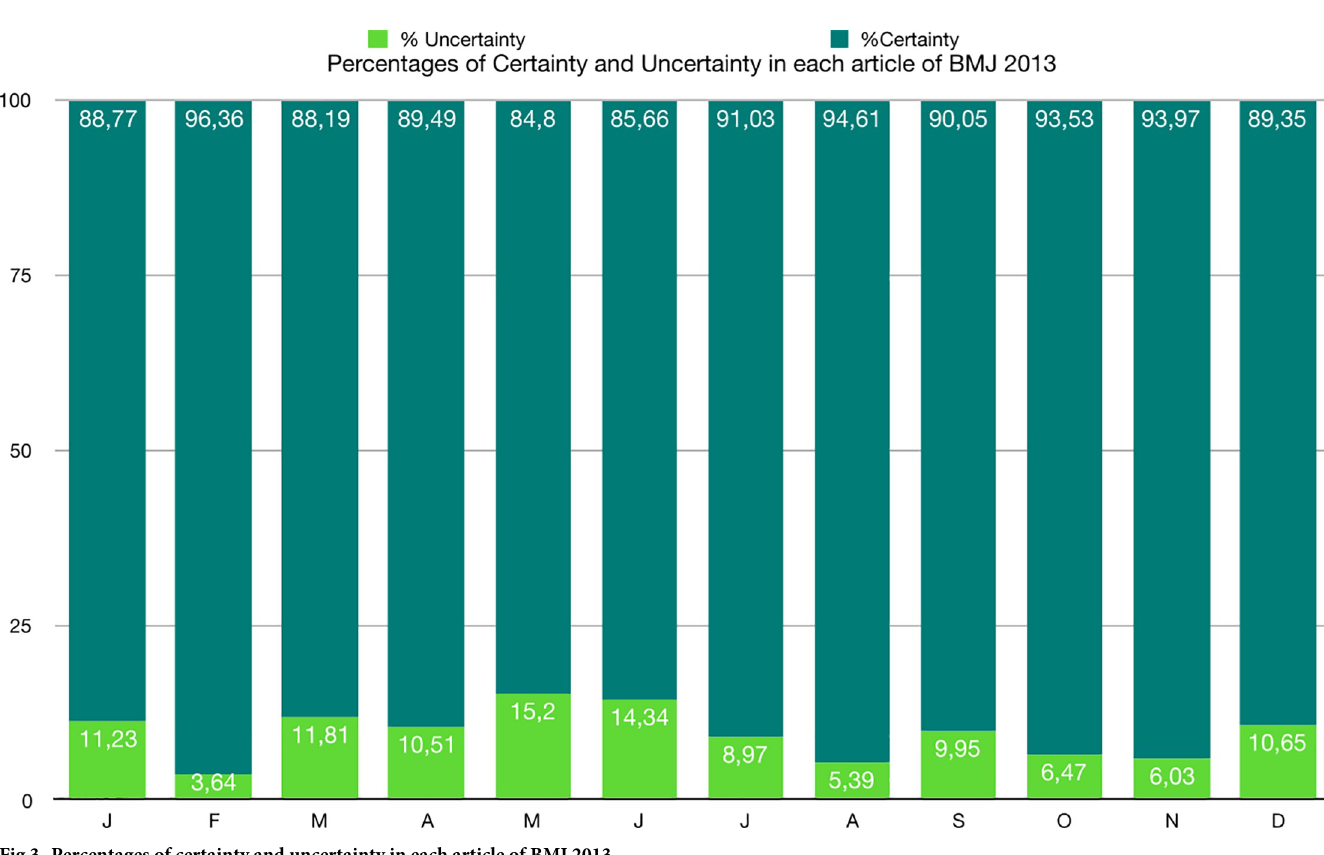
Fig 3. Percentages of certainty and uncertainty in each article of BMJ 2013. https://doi.org/10.1371/journal.pone.0221933.g003 Results Uncertainty markers. Modal verbs in the conditional mood and in the simple present are the most used UMs (Table 13). Table 11. Percentages of certainty and uncertainty in each article and in the whole corpus of BMJ 2013. Tokens Percentages Articles Certainty Uncertainty Total Certainty Uncertainty